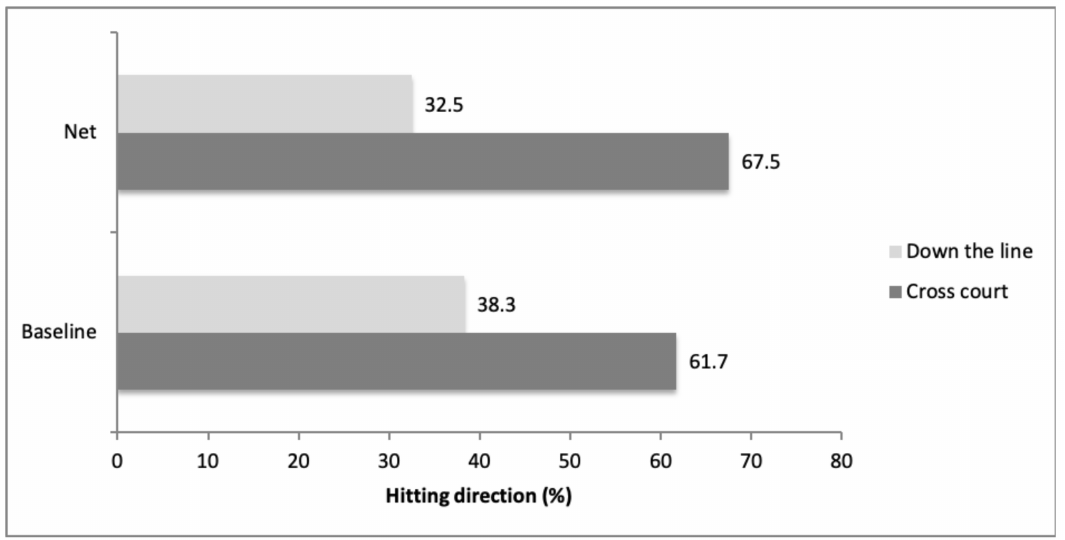
Figure 3. Distribution of the percentage of down-the-line and cross-court shots according to the court